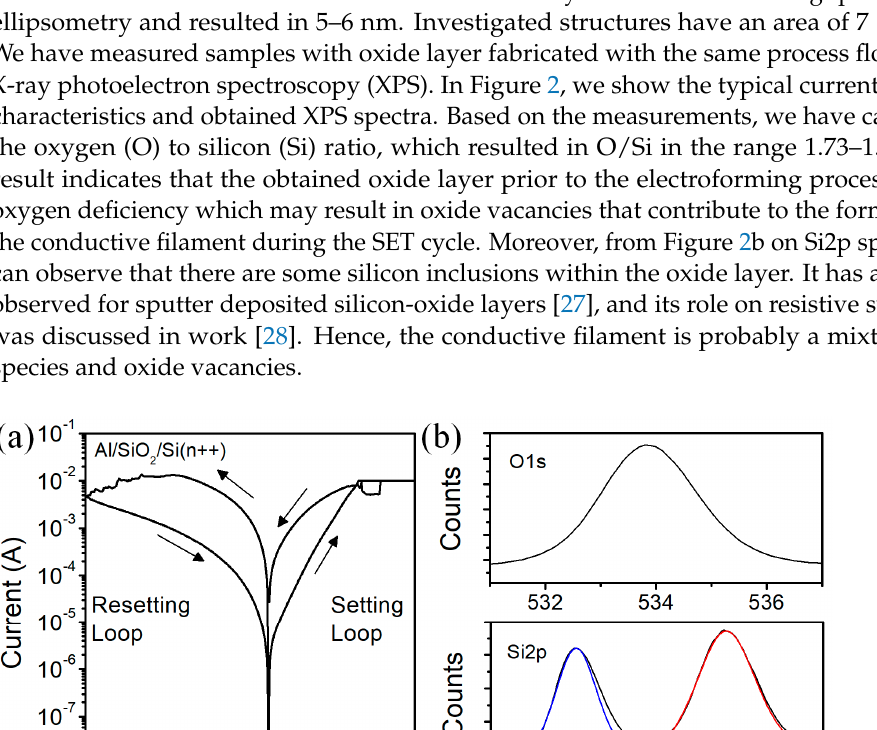
Figure 3. Forming voltage statistics ( a ) and mean forming voltage values ( b ) at different tempera- tures. We also investigated the forming process of devices with temperature and voltage bias as parameters. Based on the measurements, the forming voltage and forming time (time-to-breakdown) t bd values were extracted. The Weibull distribution had been used for oxide breakdown modeling [31,32]. Since the voltage breakdown is analogue to form- ing process in the RRAM switching layer, the same statistics was adopted to model form- ing and switching processes in resistive memory devices [33–36]. The cumulative distri- bution function for the Weibull distribution of statistical variable x is: 𝐹(cid:4666)𝑥; 𝛽, 𝜆(cid:4667) = 1 − 𝑒 (cid:2879)(cid:4672)(cid:3051) (cid:3090)(cid:4673) (cid:3329) (1) for x ≥ 0, where β > 0 is the shape parameter (or Weibull slope) that measures statistical dispersion and λ > 0 is the scale parameter, a value at which the value of statistical variable is F ≈ 0.63. When the Weibull plot is used for data presentation, the axes are ln ( − ln (1 − F(x ))) versus ln ( x ), and then the cumulative distribution function can be linearized, since